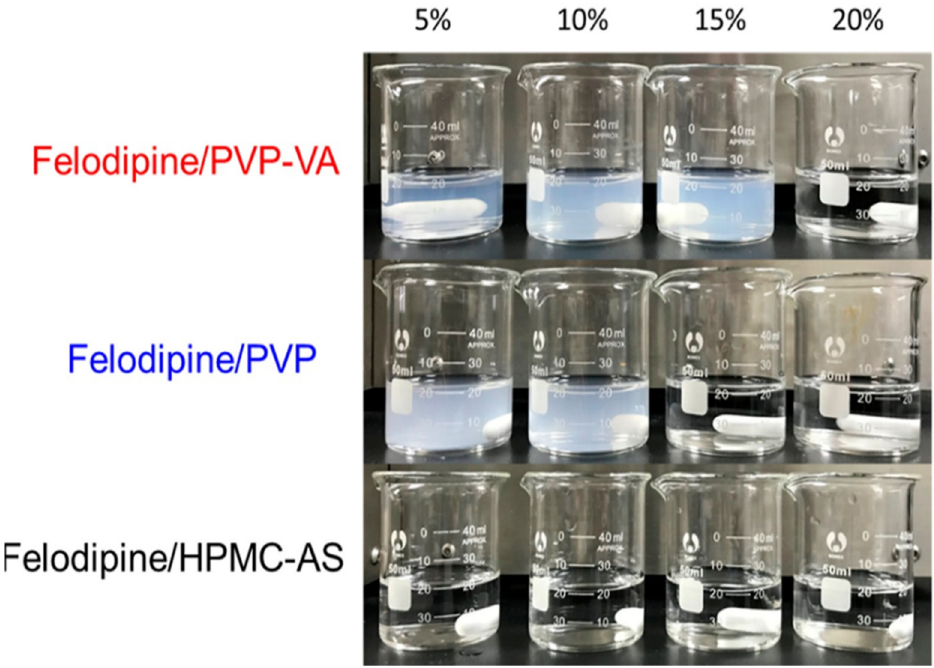
Figure 8. Appearance of dissolution media after 5 min of dissolution of Felodipine containing PVPVA, PVP, or HPMCAS in 0.05 M hydrochloric acid solution as a function of drug loading. Adapted from Ref. [105] with Copyright © 2022 American Chemical Society.